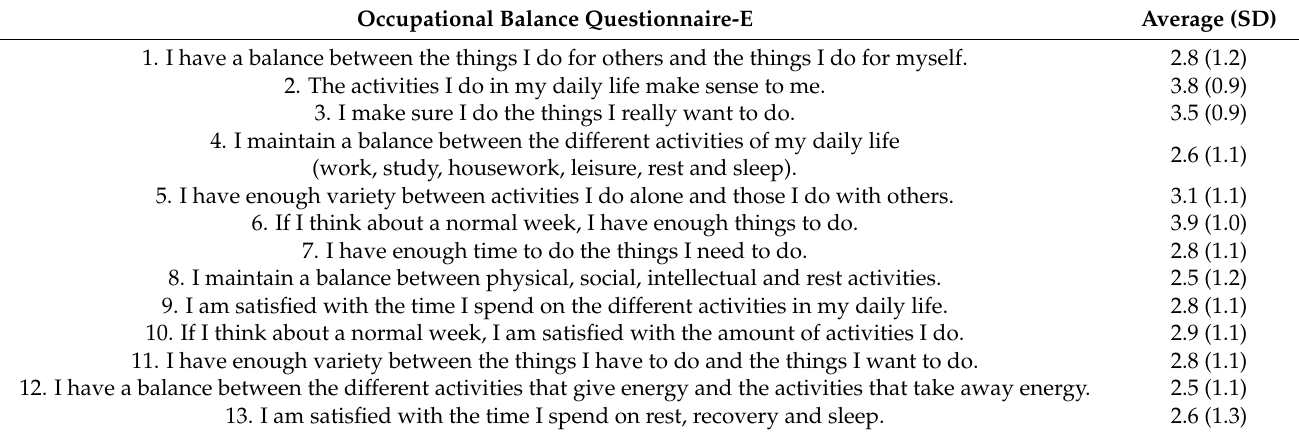
Table 3. Average values obtained in the items of the OBQ-E instrument (n =